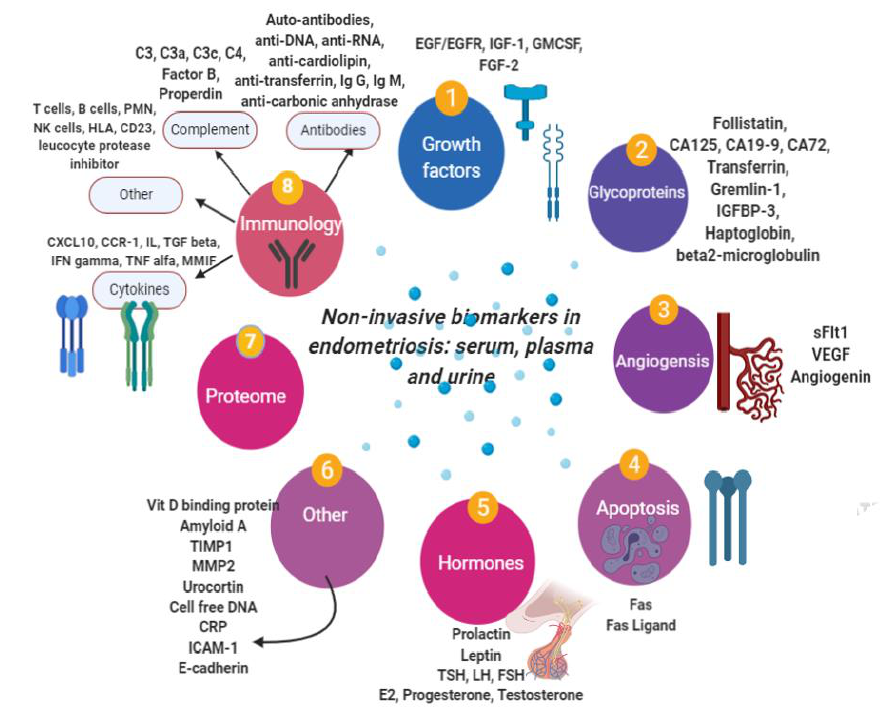
Figure 1. Putative noninvasive biomarkers for endometriosis [12].